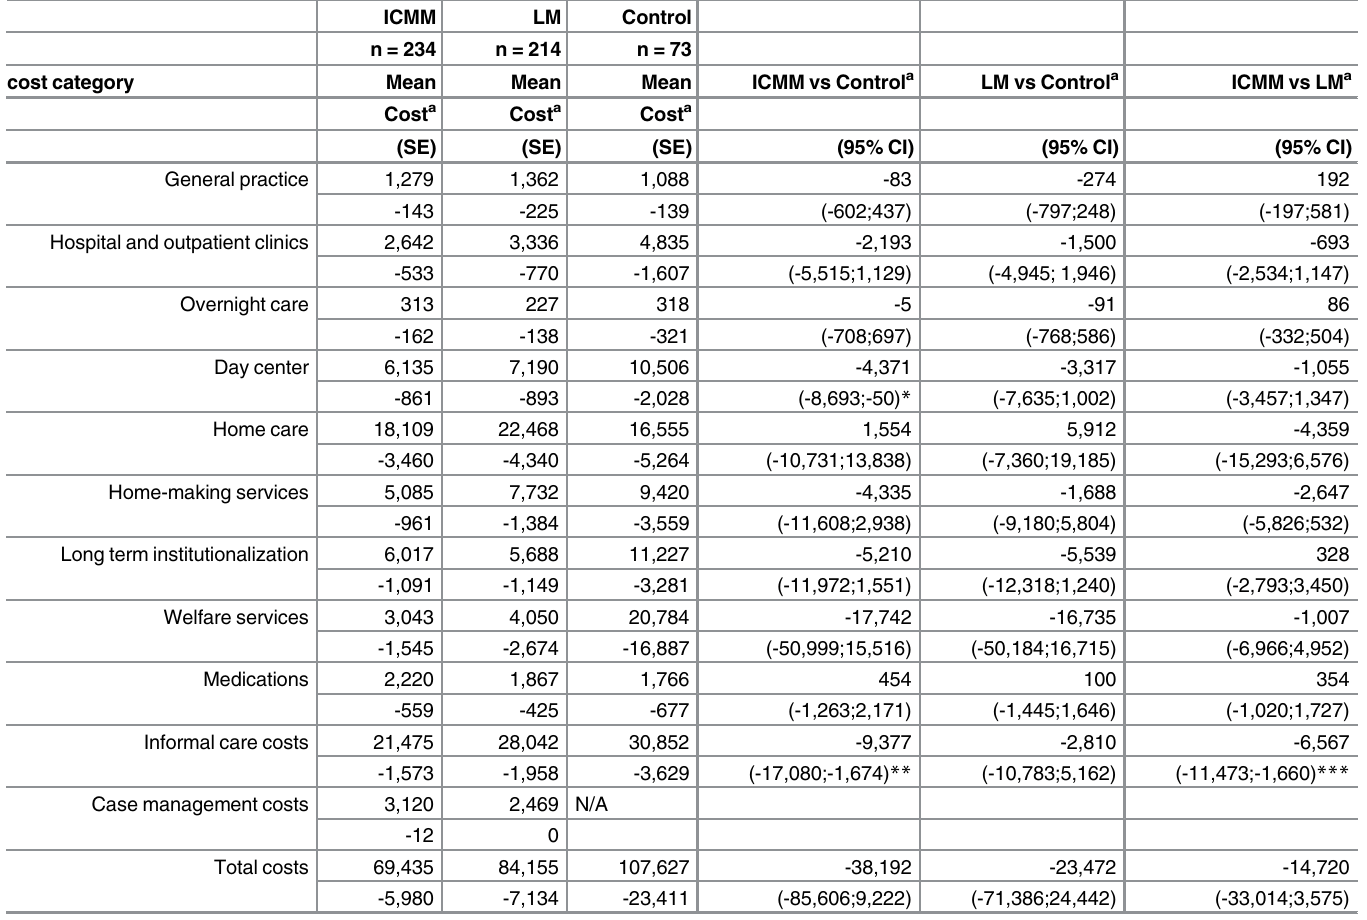
Table 3. Adjusted sub costs and costs along with differences between groups over 24 months (in